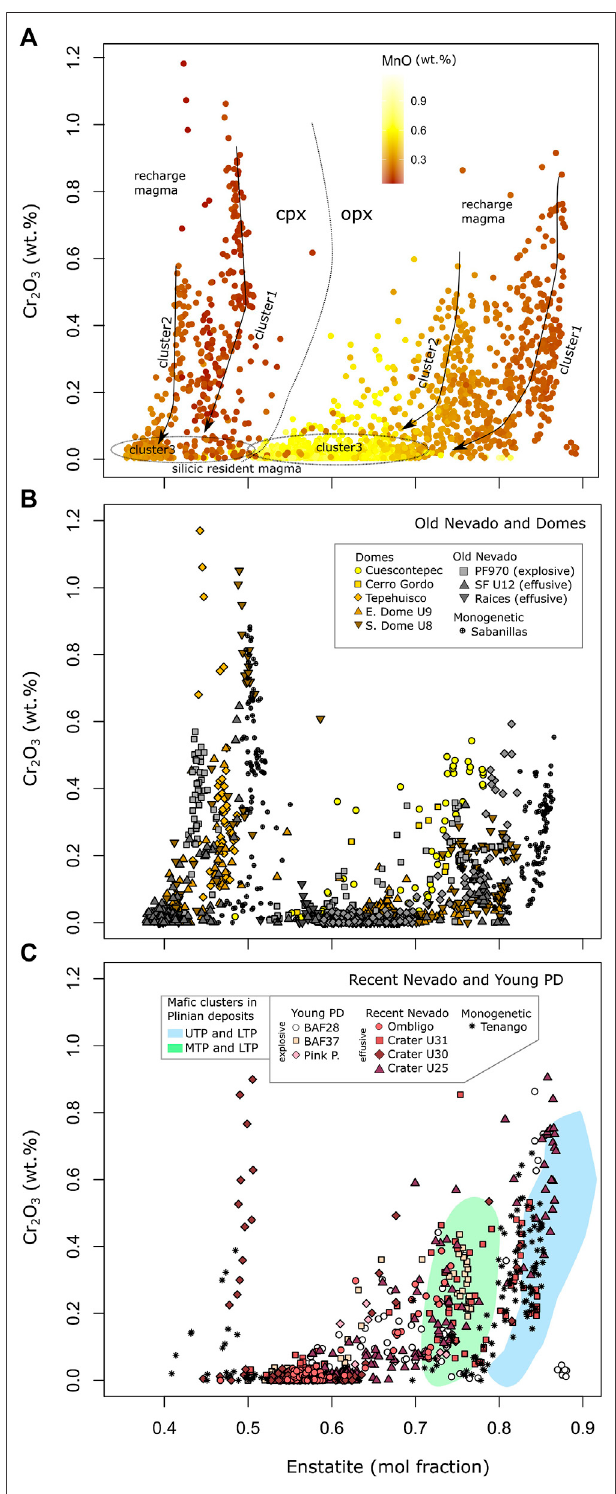
FIGURE 6 | Systematics of Enstatite (mol%) (En) content and Cr 2 O 3 (wt %) in Nevado de Toluca clino- and orthopyroxenes. (A) Data spanning the entire 1.5 Ma history of the volcano. Color coding indicates MnO (wt%) content of the pyroxenes. Clino- and orthopyroxene cores show